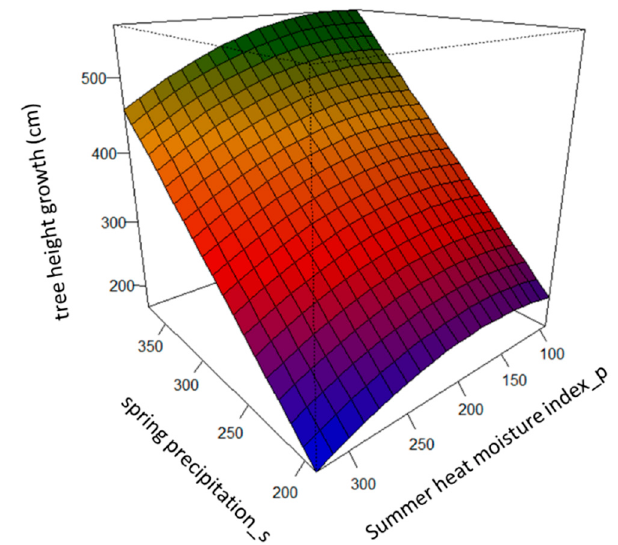
Table 4. Predictions of local tree height growth, H L (cm), and optimum tree height growth, H OPT (cm), for each population, based upon the best supported model.